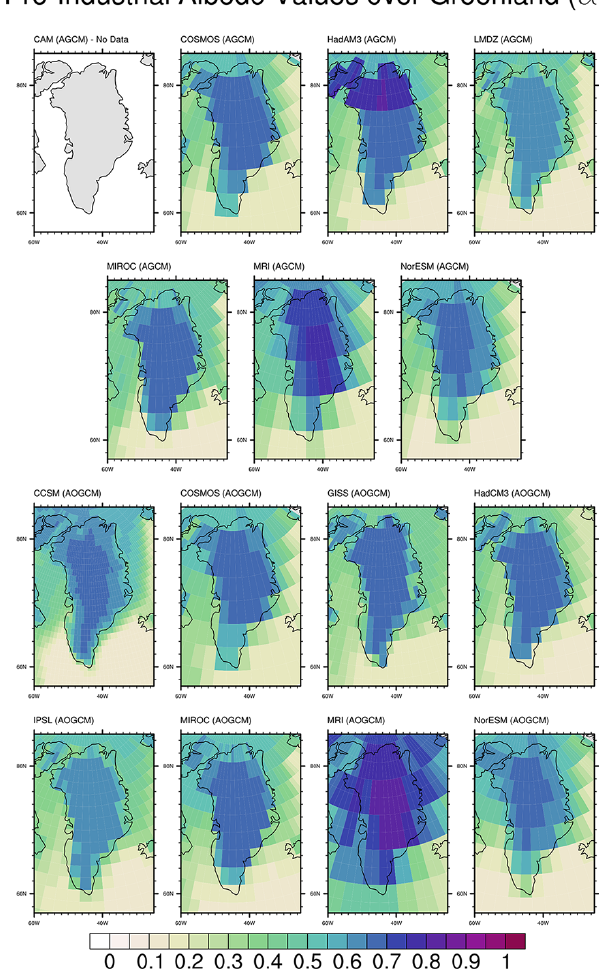
Figure 10. Pre-industrial annual mean clear sky albedo values over Greenland for PlioMIP models (where available).